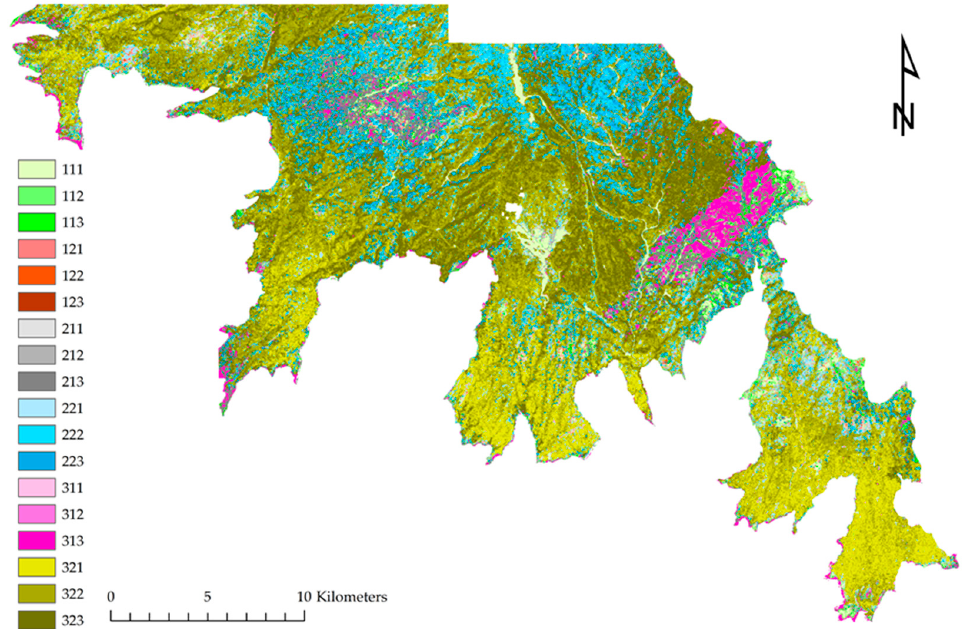
Figure 5. Structure classes on the North Rim of the Grand Canyon. Classes 321 and 322 are dominant on the lower elevation peninsulas. Areas that are dominated by post high severity aspen stand out as class 313. Grassy areas are all classified as 111.